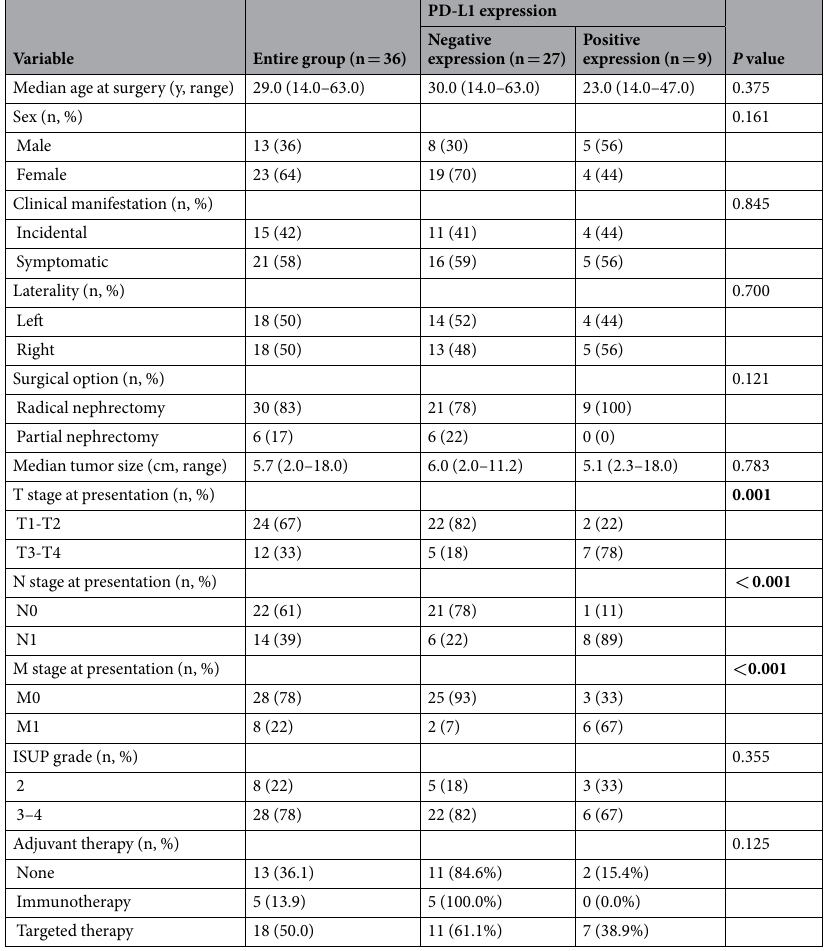
Table 1. Clinicopathological characteristics in relation to PD-L1 expression status.